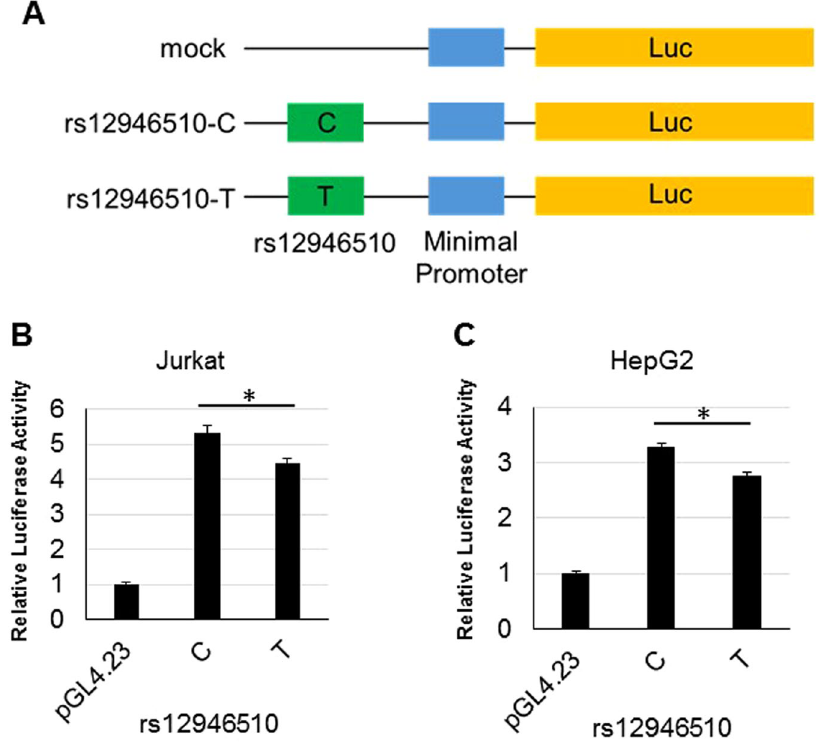
Figure 3. Luciferase reporter assay of rs12946510. ( A ) Outline of the luciferase reporter plasmid constructs used for transfection. The plasmids consisted of PCR fragments of the genomic DNA between GRB7 and IKZF3 containing rs12946510 that were sub-cloned into the pGL4.23 vector. ( B and C ) The ability of these plasmid constructs to enhance transcription in transfected Jurkat ( B ) and HepG2 ( C ) cells was measured by determination of cellular luciferase (luc) activity 24 hours after transfection. The luciferase activities of cells transfected with the PBC susceptibility allele (T-allele) of rs12946510 were reduced compared to those transfected with the major allele (C-allele). Three independent experiments were performed in each assay. The data in the figures represent averages ± standard deviation of triplicate assays in one experiment. * P < 0.001 (Student’s t